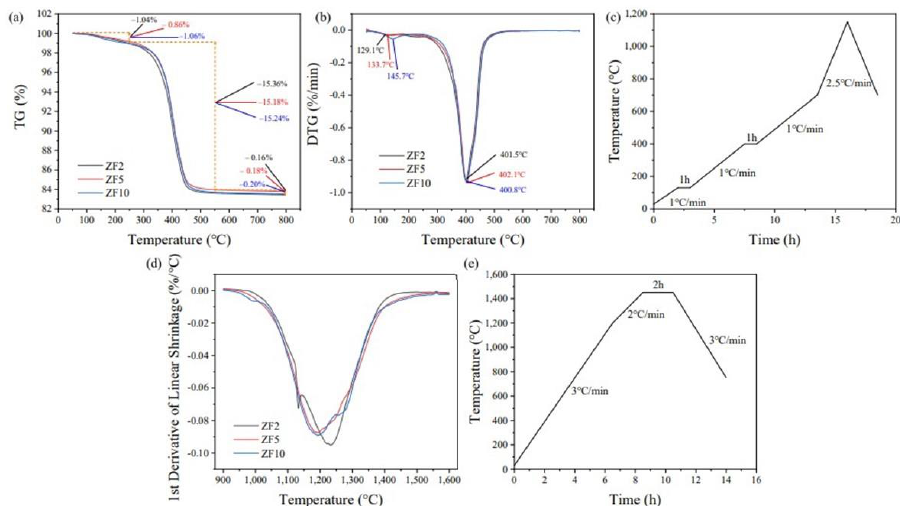
Figure 10. The ( a ) thermogravimetry (TG) curves, ( b ) derivative thermogravimetry (DTG) curves and ( c ) the detail debinding curves of the green parts with various particle sizes, and ( d ) the first- derivative of linear shrinkage in the Z direction and ( e ) detail sintering curve of the parts with various particle sizes.